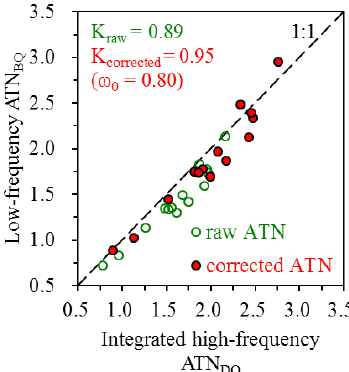
Figure 5. Comparison of the low-frequency ATN BQ and the inte- grated high-frequency ATN DQ . The comparison is performed based on both the uncorrected and corrected ATN. The correction is made by Eqs. (5)–(7) in which ω 0 is assumed to be 0.80. The correction has also been made by assuming ω 0 = 0 . 85 and 0.90, but the results are not presented here. Linear regression results are shown with K as slope (intercept is set as 0). For the uncorrected ATN results, the difference between the low-frequency ATN BQ and the integrated high-frequency ATN DQ is significant at a 95% level of confidence (two-tailed p = 0 .